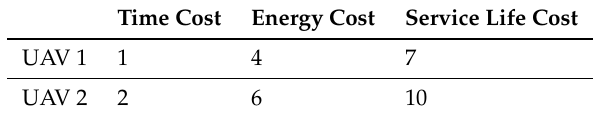
Table 3. Cost of unmanned aerial vehicles (UAVs) by Task 1.